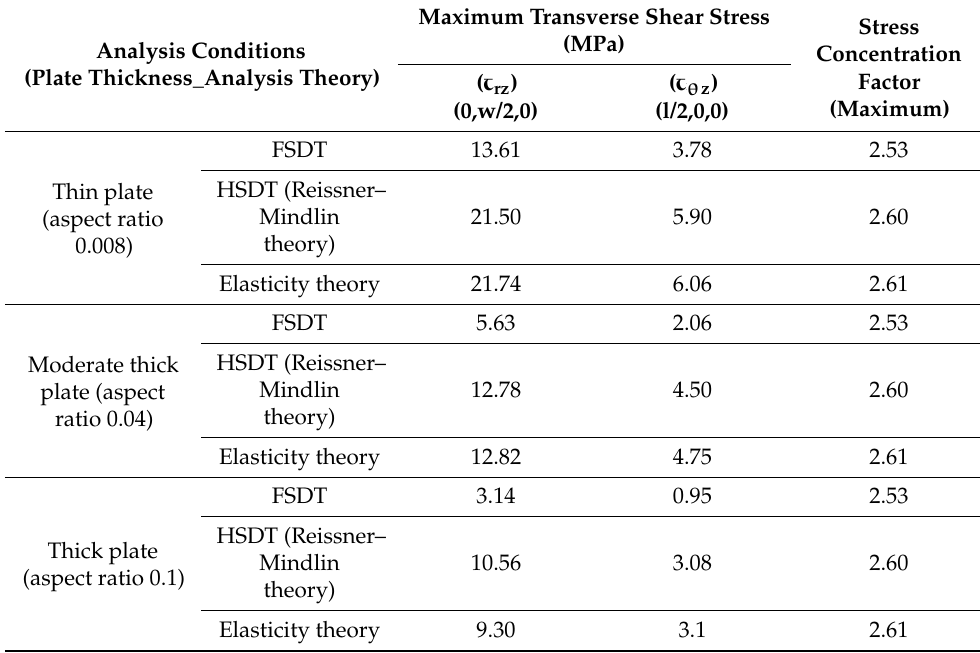
Table 2. Transverse shear stress and SCF for a braided polymer material.